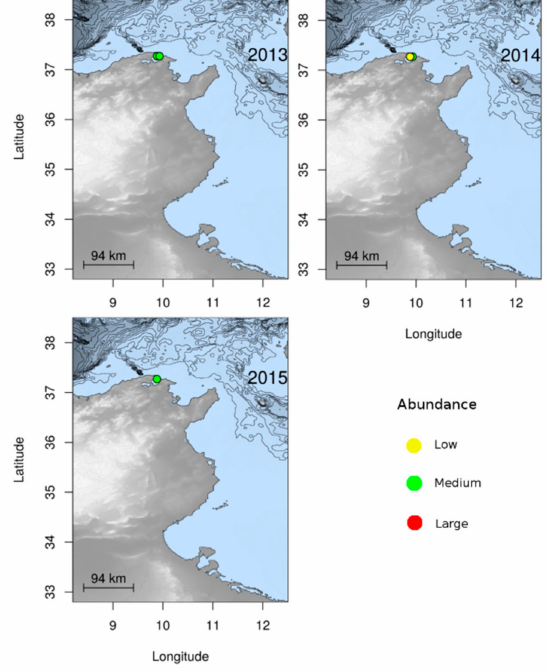
Figure 12. Spatial distribution of jellyfish reports from 2013 (upper-left panel) to 2015 (lower-left panel) for Rhizostoma pulmo in Tunisia. Abundance categories are shown as follows: category 1—“low” in yellow, category 2—“medium” in green, and category 3—“high” in